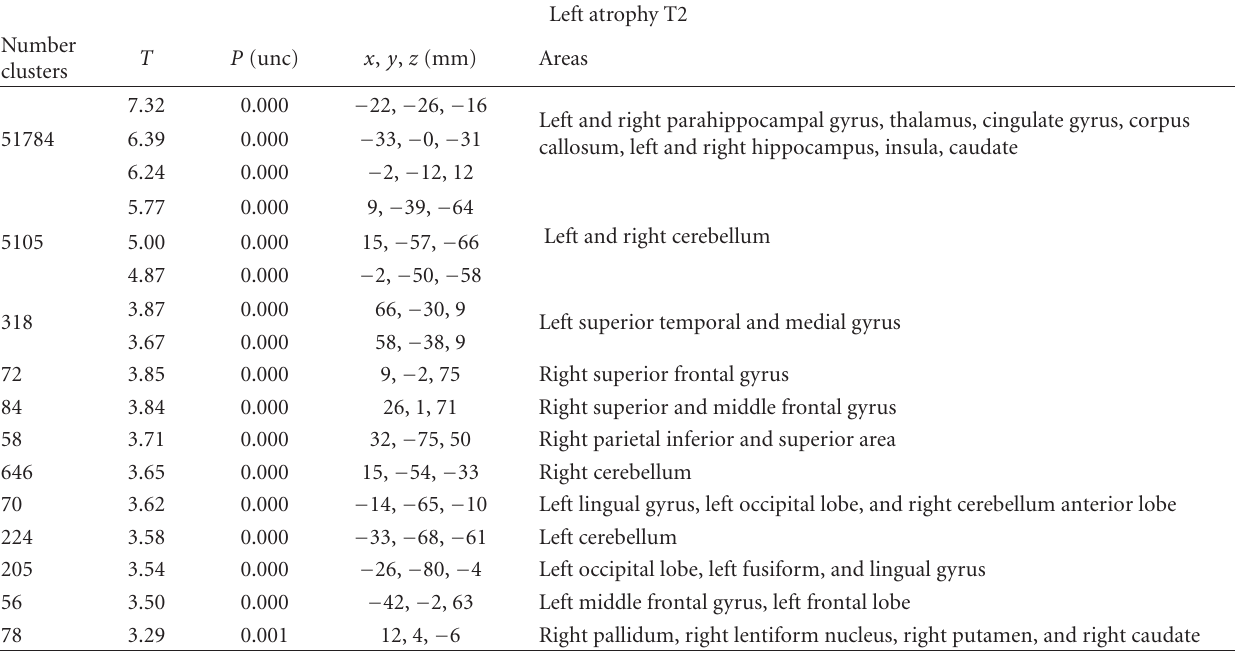
Table 3: Areas with WM atrophy on patients with left HA, from T2-weighted analysis. Left atrophy